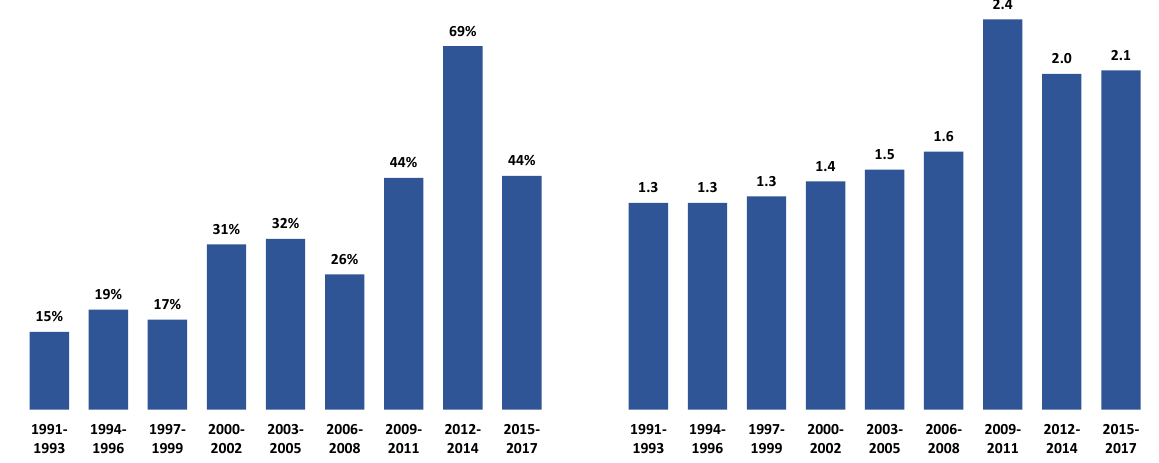
Figure 6: New assistant professors with a gap of one or more years between obtaining their PhDs and starting their first assistant professor positions by year. Shown are the percentage with one or more gap years and the mean number of gap years among those with any